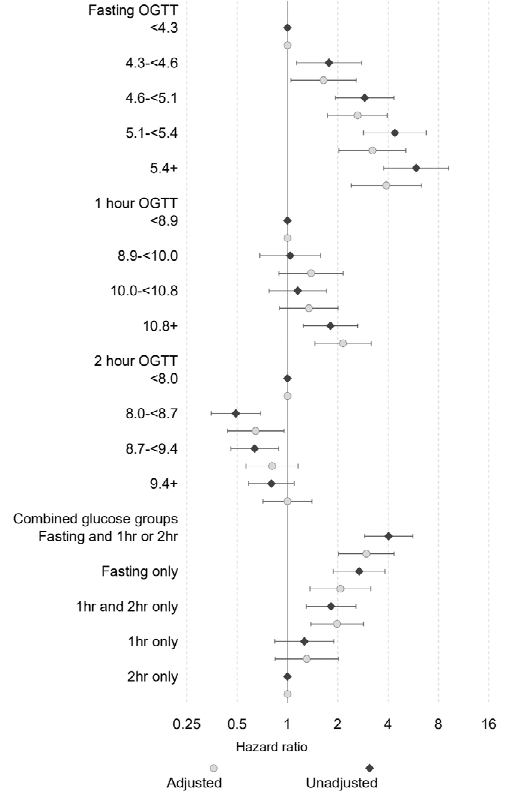
Figure 1. Hazard ratio for medication by glucose tolerance test result categories.